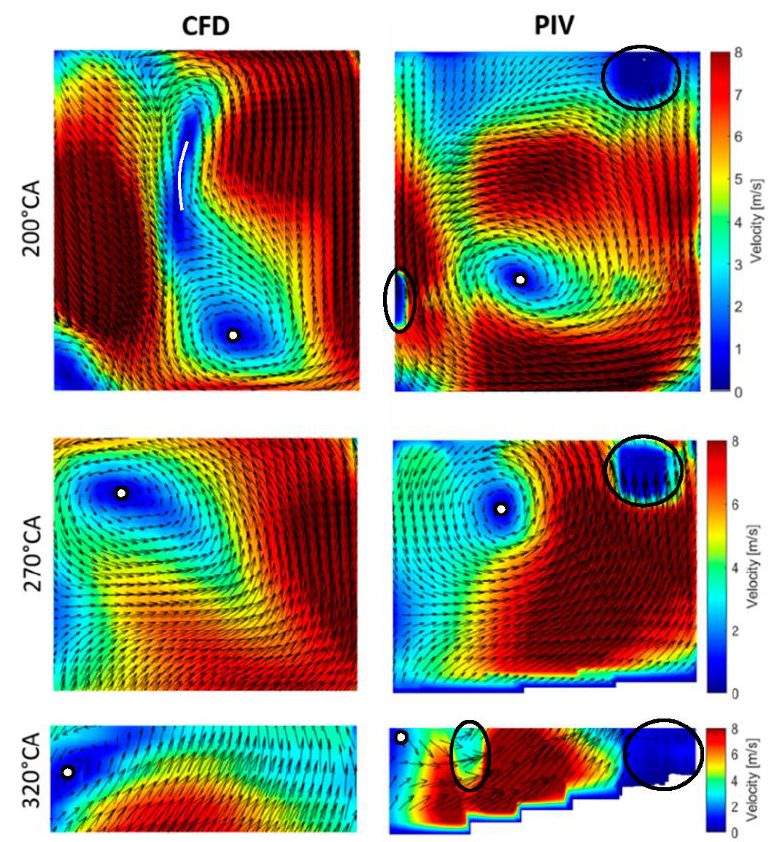
Figure 10. Mean flow velocity fields: simulation ( left ) and experiment ( right ) — VVT in/ex = 20/00 .